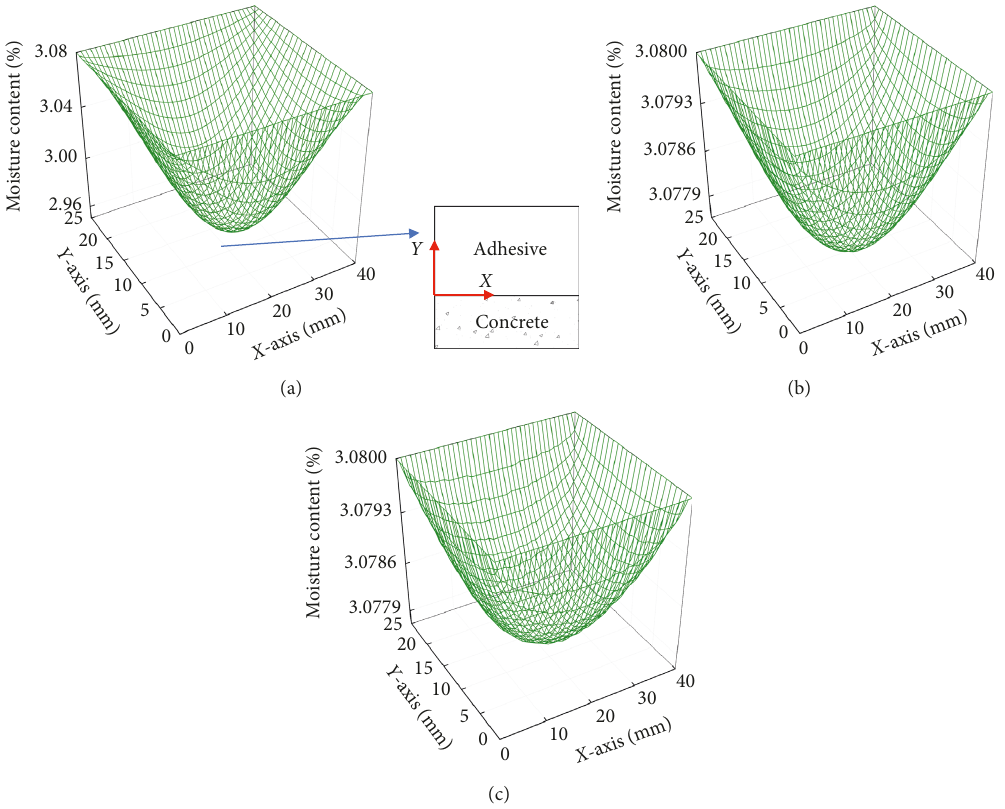
Figure 11: Typical FEM results of the moisture content distribution: (a) 2 weeks, (b) 4 weeks, and (c) 6 weeks.